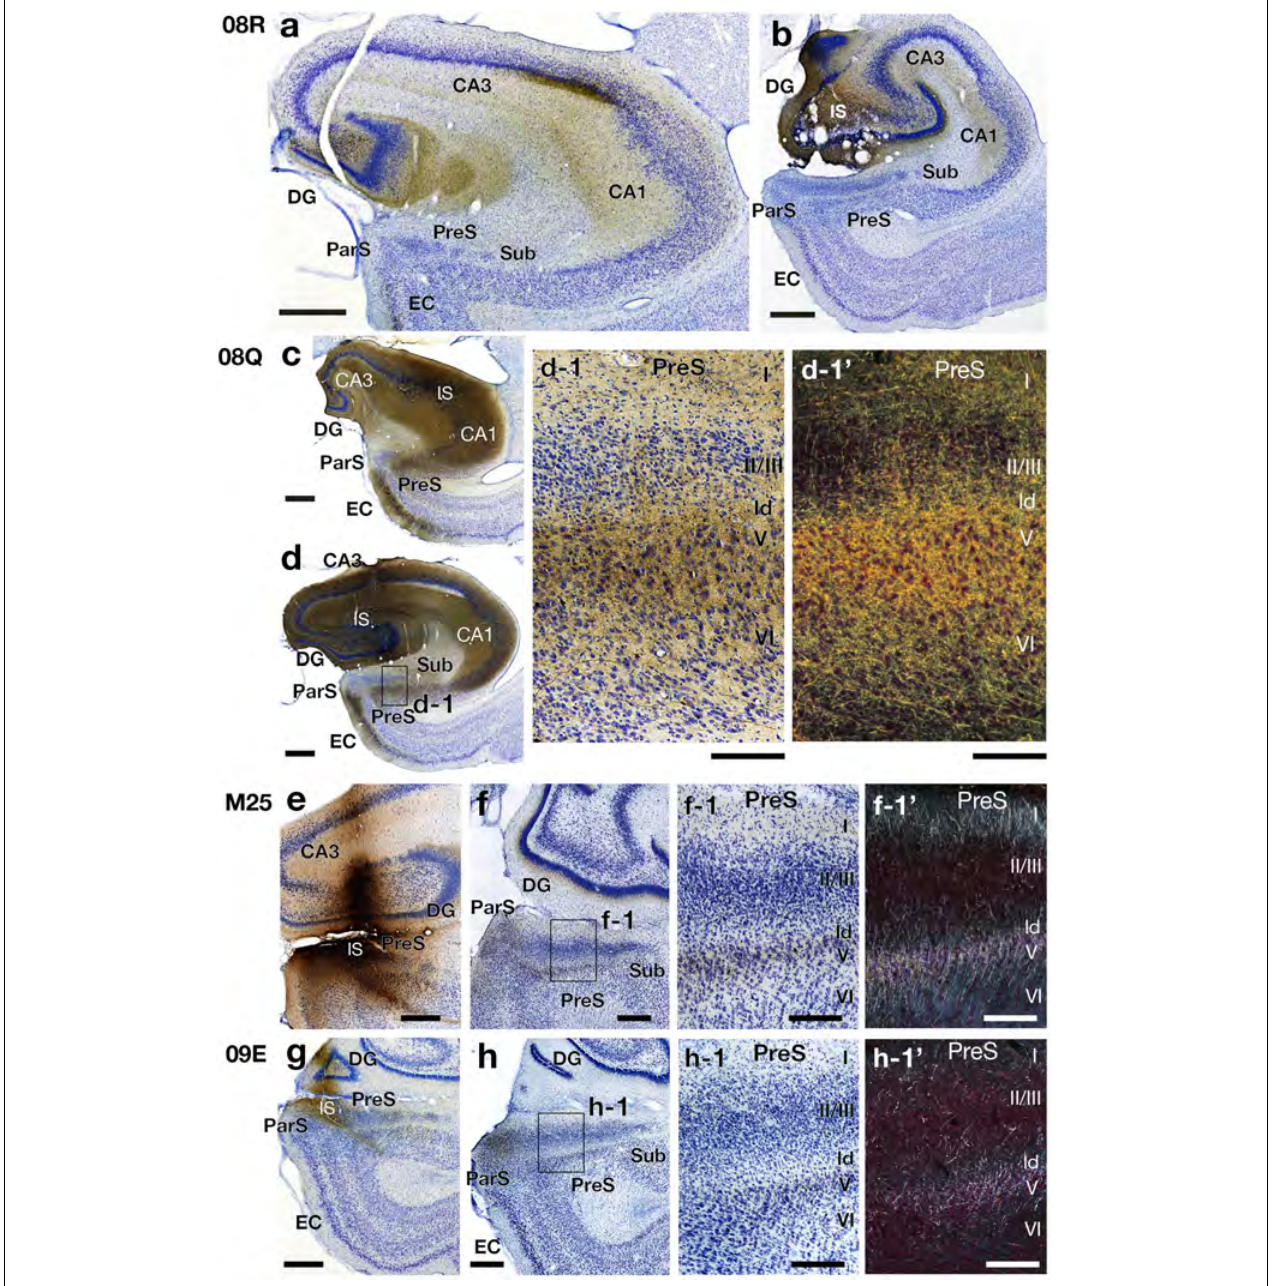
FIGURE 7 | Photomicrographs of the hippocampal and parahippocampal areas in four BDA injection cases (cases 08R, 08Q, M25, and 09E) on the same side of the injection (right hemisphere). High-magnification images of rectangles in d, f, and h are represented in d-1, f-1, and h-1, respectively. Panels d-1’, f-1’ and h-1’ are dark-field images of the same section as d-1, f-1 and h-1, respectively. Scale bar = 200 µ m in panels a, b, c, d, f-1, f-1’, h-1 and h-1’, 500 µ m in e, f, g, and h and 50 µ m in d-1 and d-1’. CA, cornu ammonis; DG, dentate gyrus; EC, entorhinal cortex; IS, injection site; ld, lamina dissecans; ParS, parasubiculum; PreS, presubiculum; Sub, subiculum. Note that, the BDA injection site included CA1 in case 08Q but not included in case 08R. In case 08Q, many fibers and terminal boutons were labeled in layers I, V and VI along with ld in PreS. On the other hand, in case 08R, there were almost no labels in PreS. Also note that in cases M25 and 09E, which injection sites contained a part of PreS, labeled fibers and terminals were observed in layers I, II, and V along with ld in